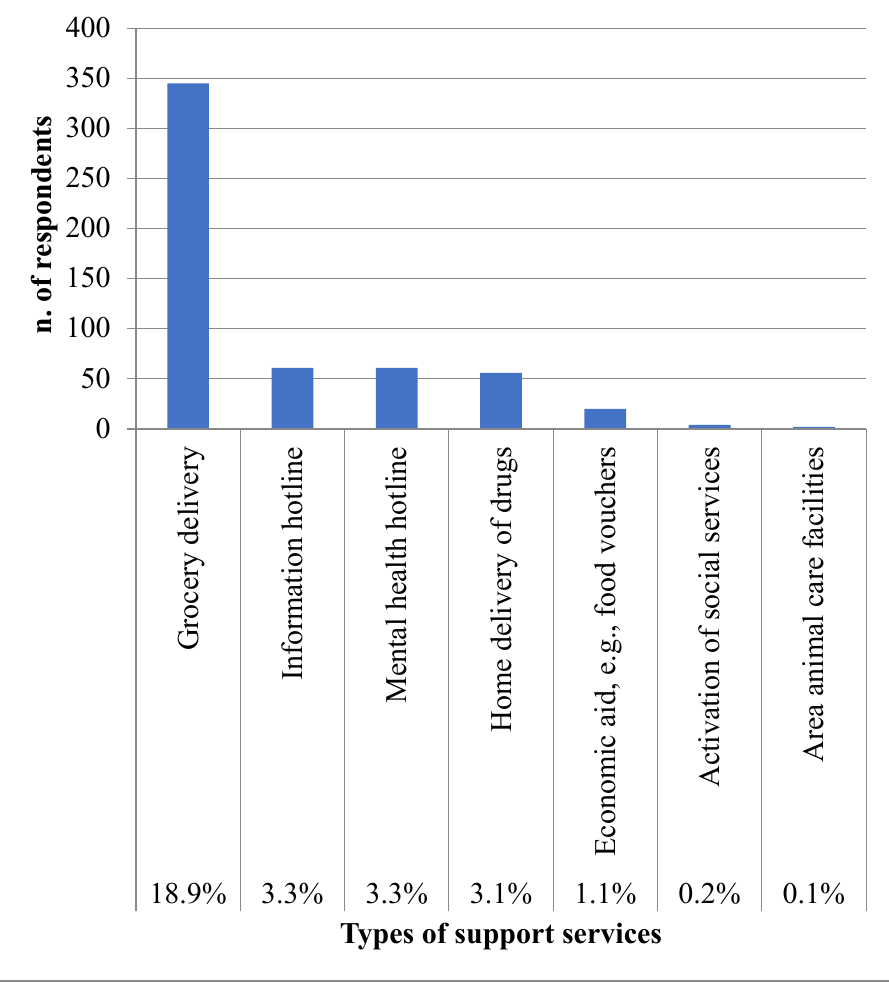
Figure 3. Percentages of participants who used support services, described also as types, during the first lockdown.